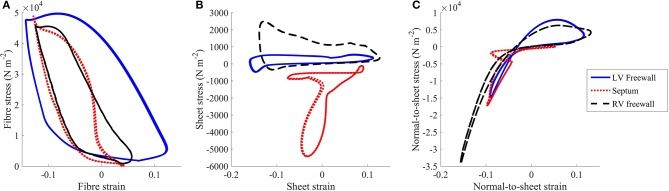
Stress vs. strain plots taken from the (A) fiber, (B) sheet, and (C) normal-to-sheet components of the 2nd Piola-Kirchoff stress and Green-Lagrange strain tensors. The results are taken from the standard healthy model at the third cycle (t = 2,000–3,000 ms).